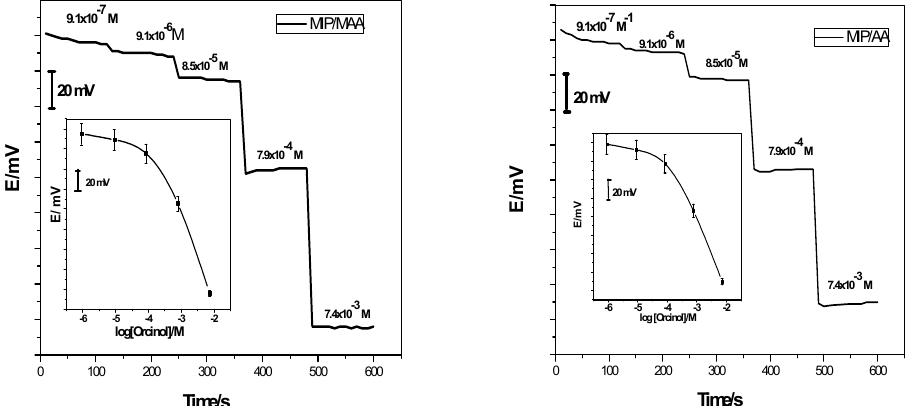
Figure 4. Trace of liquid-contact orcinol-ion-selective electrodes in orcinol concentration. The inset shows the calibration curve of the proposed